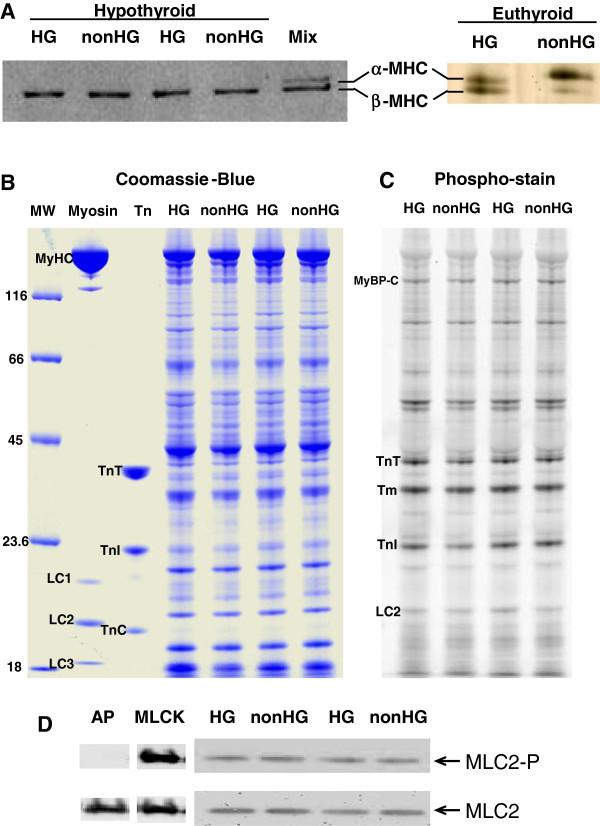
Myosin isoforms and myofibrillar protein phosphorylation.A. Gel electrophoresis stained with Coomassie-Blue demonstrate 100% β-MyHC content in both HG and nonHG groups due to hypothyroidism. In euthyroid rats, HG results in a significant upregulation of cardiac β-MyHC compared to the α-MyHC predominately expressed in the nonHG rat heart. B and C. Coomassie-blue and phospho-stain by Pro-Q Diamond indicated similar phosphorylation profiles of myofibrillar proteins in HG and nonHG. D. Western blots of phosphorylated MLC2 (MLC2-P) and total MLC content demonstrated similar degrees of phosphorylation in HG and nonHG controls. Additional lanes indicating alkaline phosphatase (AP) treatment to dephosphorylate MLC2 and myosin light chain kinase (MLCK) treatment to phosphorylate MLC2 provided negative and positive controls for MLC2 phosphorylation. Myosin = chicken skeletal myosin standard, Tn = bovine cardiac troponin standard, MyBP-C = myosin binding protein-C, Tm = tropomyosin, LC = myosin light chain.